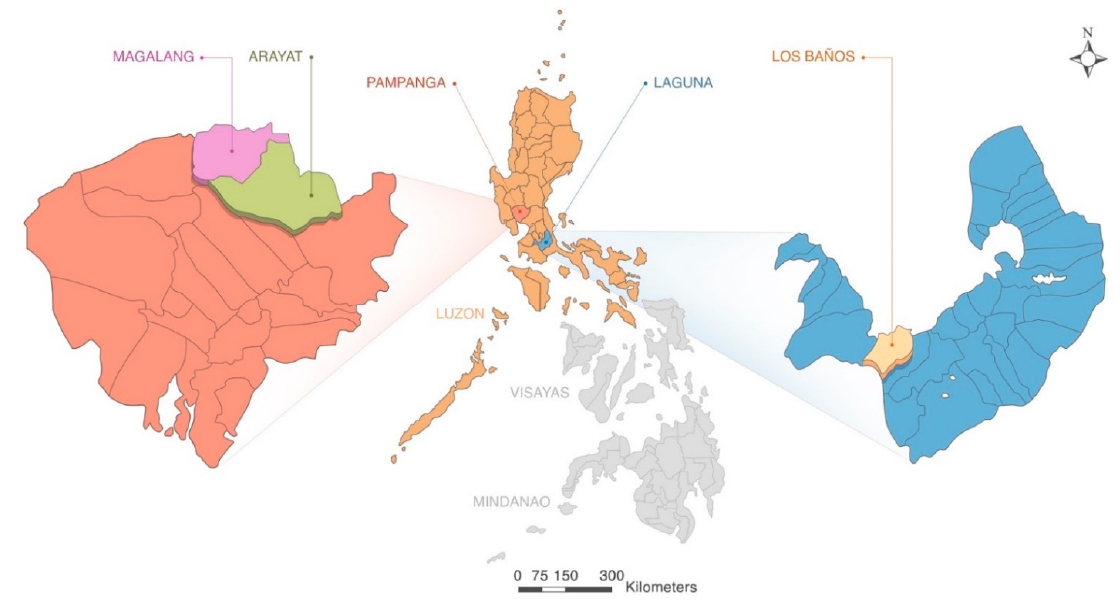
Figure 2. Sampling sites of the study.